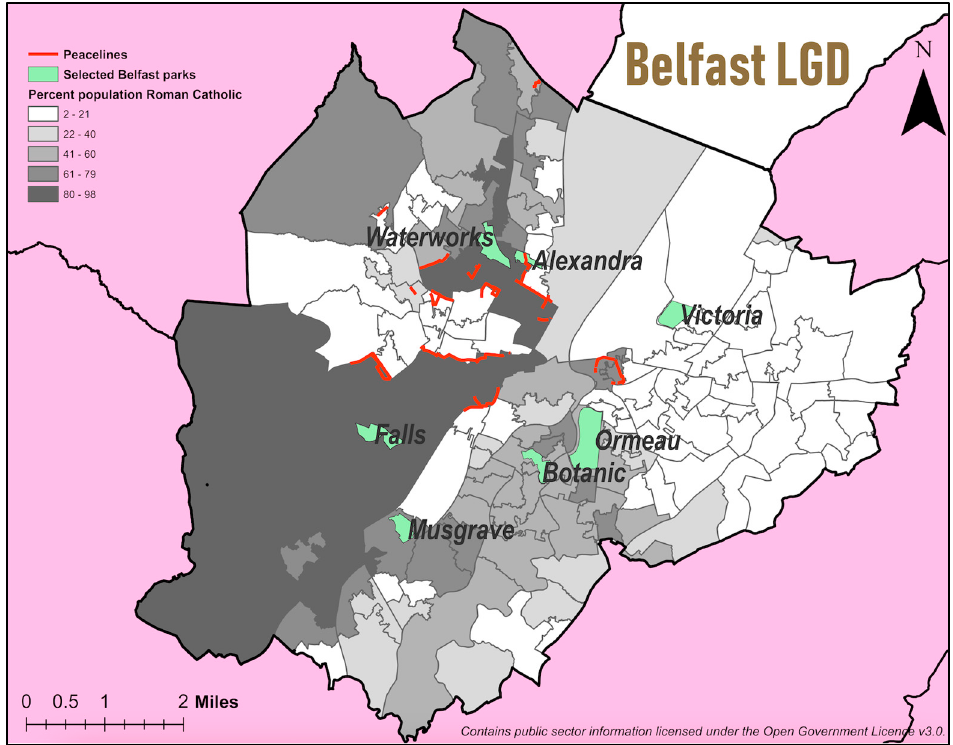
Figure 1. Park locations and survey sites in Belfast.